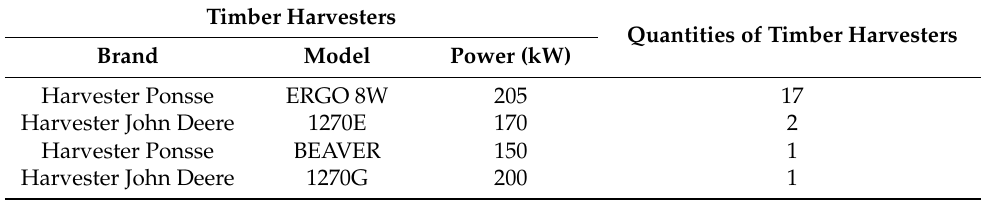
Table 1. Technical specifications of timber harvesters used in cutting and processing trees. Timber